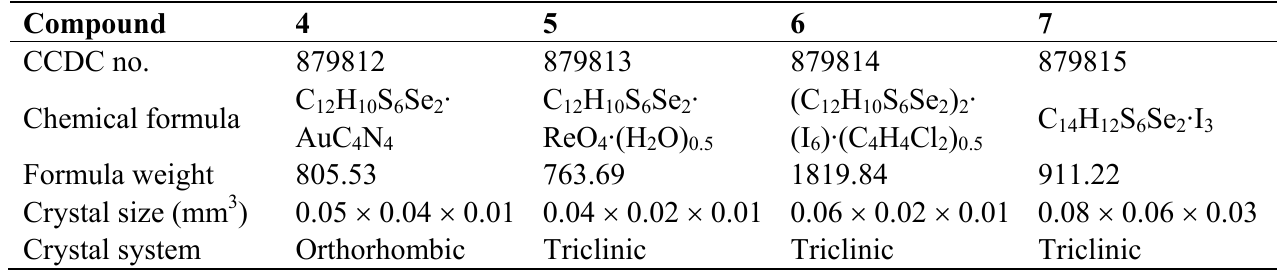
Table 3. Crystal data, structure refinement details and electrical properties for 4 − 7